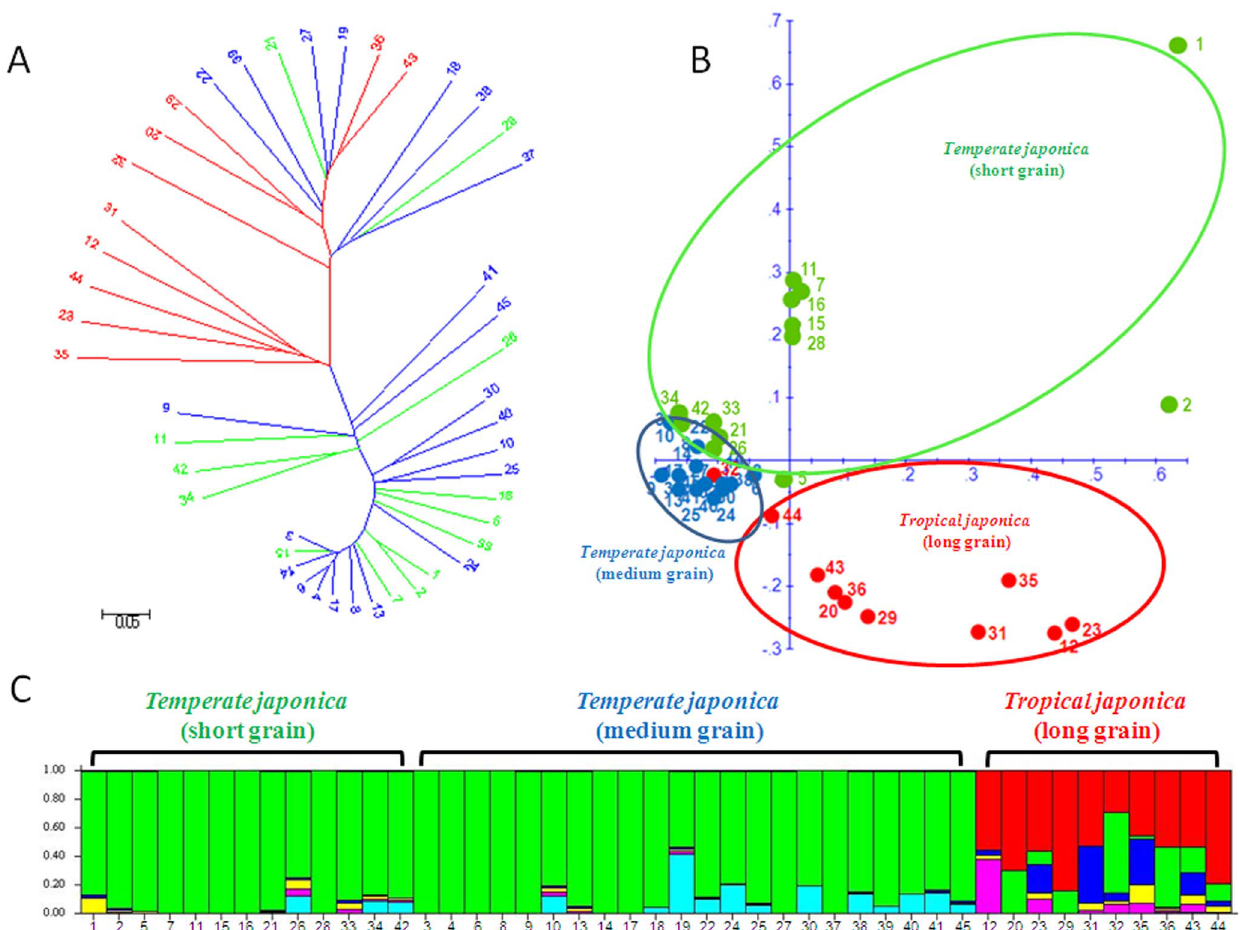
Figure 4. Phylogenic analysis of 45 California cultivars. (A) Unrooted neighbor-joining tree showing genetic relationships among the cultivars based on C.S. Chord distance calculated using 4,469 SNPs (B) Principal-coordinates analysis (PCA) plot showing that temperate japonica medium grain group is clearly distinguished from tropical japonica group. The X and Y-axes show PC1 and PC2, respectively, of the PCA analysis of the SSR data. (C) Population structure analysis plots (K=4) generated using the STRUCTURE program. The colors of the numbers represent the respective groups: red, temperate japonica (short grain); black, temperate japonica (medium grain); blue, tropical japonica (long grain) respectively.